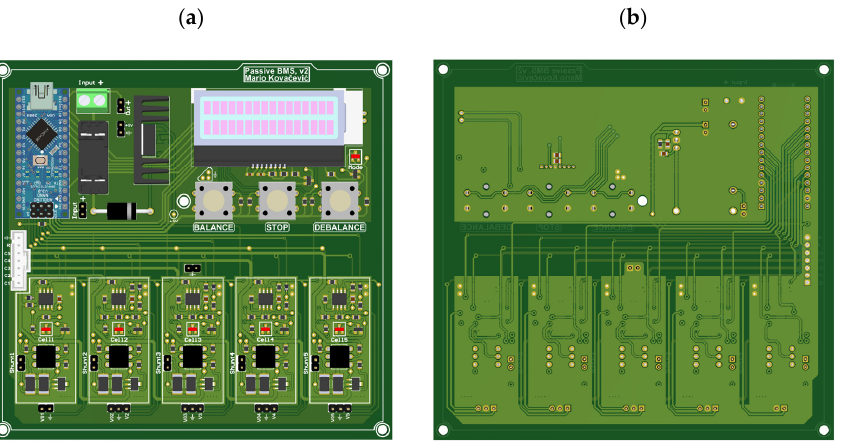
Figure 8. Top ( a ) and bottom ( b ) view of PCB assembly.